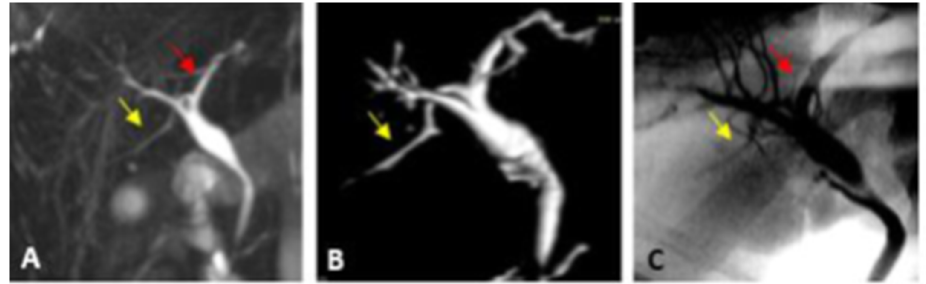
Figure 2. Classic type I biliary anatomy. ( A ) Coronal oblique thin slap heavy T2 FAT SAT FSE image shows RPSD (yellow arrow) joining the RASD (red arrow) to form the RHD. ( B ) Superior view of the post ‐ processed 3D VR coronal oblique image shows RPSD draining into the RHD. ( C ) IOC AP view image confirms the MRCP findings. It shows a small IHB duct of segment VI joining the small IHB duct of segment VII to form the RPSD (yellow arrow), which joins the RASD (red arrow) to form the RHD at a distance >1 cm from the confluence of both hepatic ducts.